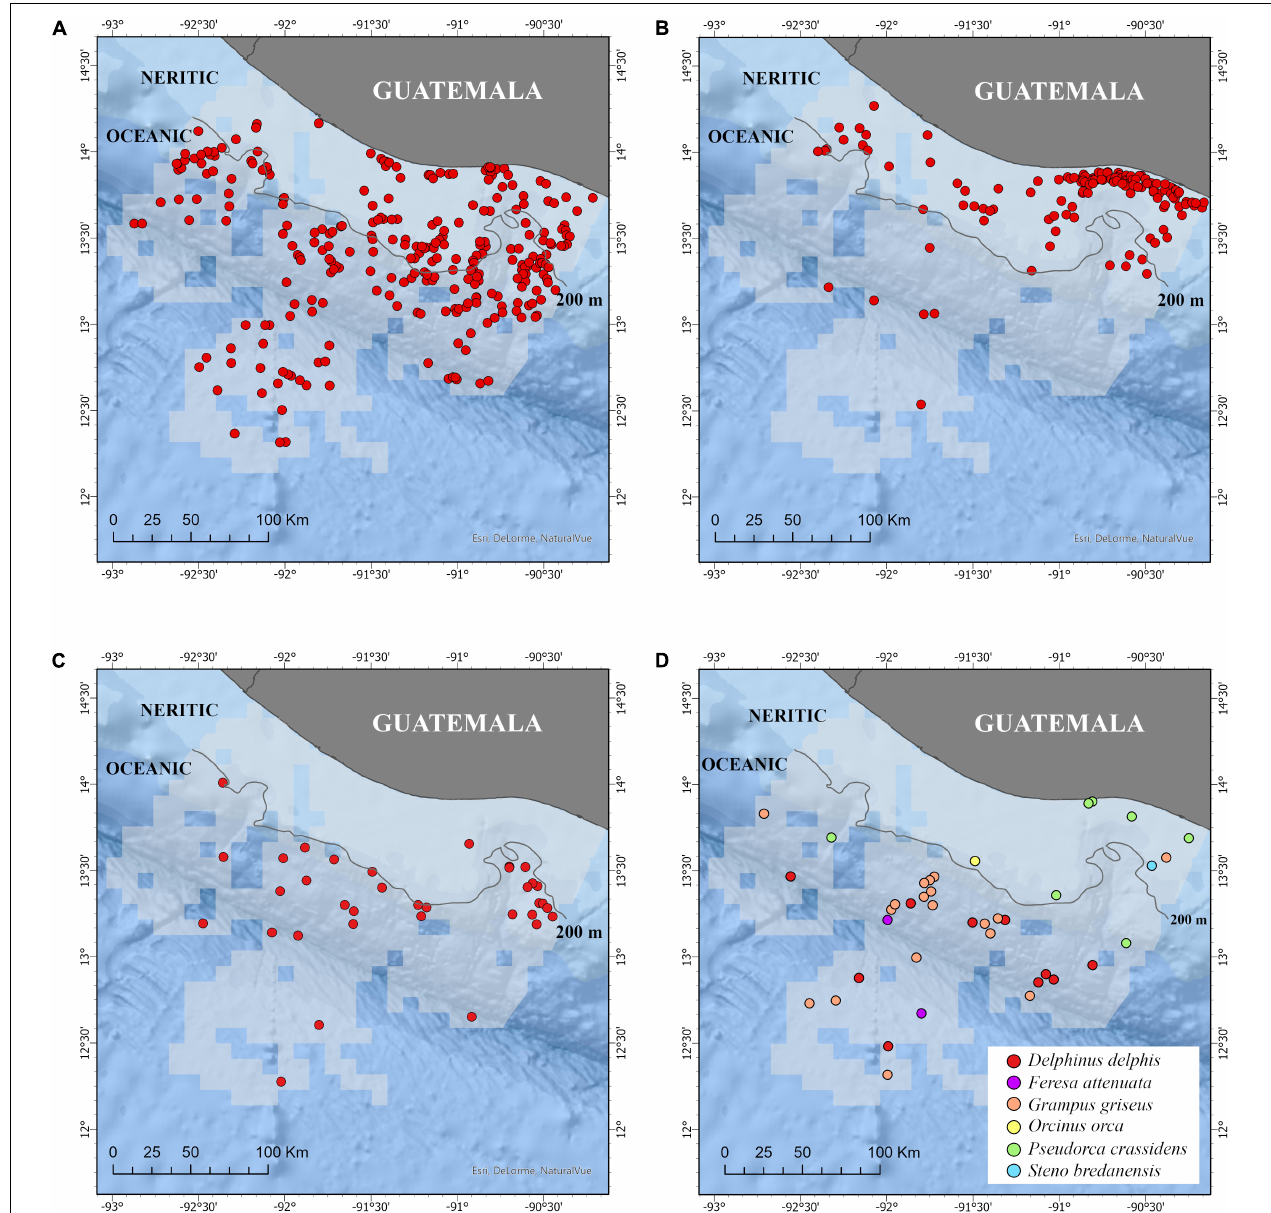
FIGURE 2 | Sightings of the three most common species: (A) Tursiops truncatus , (B) Stenella attenuata , and (C) Stenella longirostris, and (D) of the least common species in the study area (light gray) in the Pacific waters of Guatemala. Neritic and oceanic zones, 200 m isobath, and coastal marine protected areas (medium gray color) are also included. Additional details of the study area are shown in Figure 1